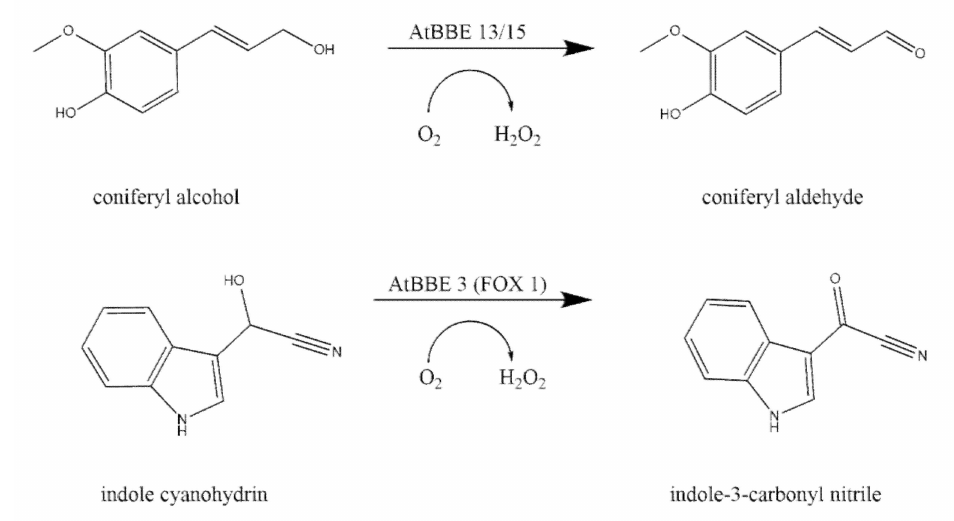
Figure 6. Enzymatic reactions catalyzed by A. thaliana ( At ) BBE-like proteins in A. thaliana [54].